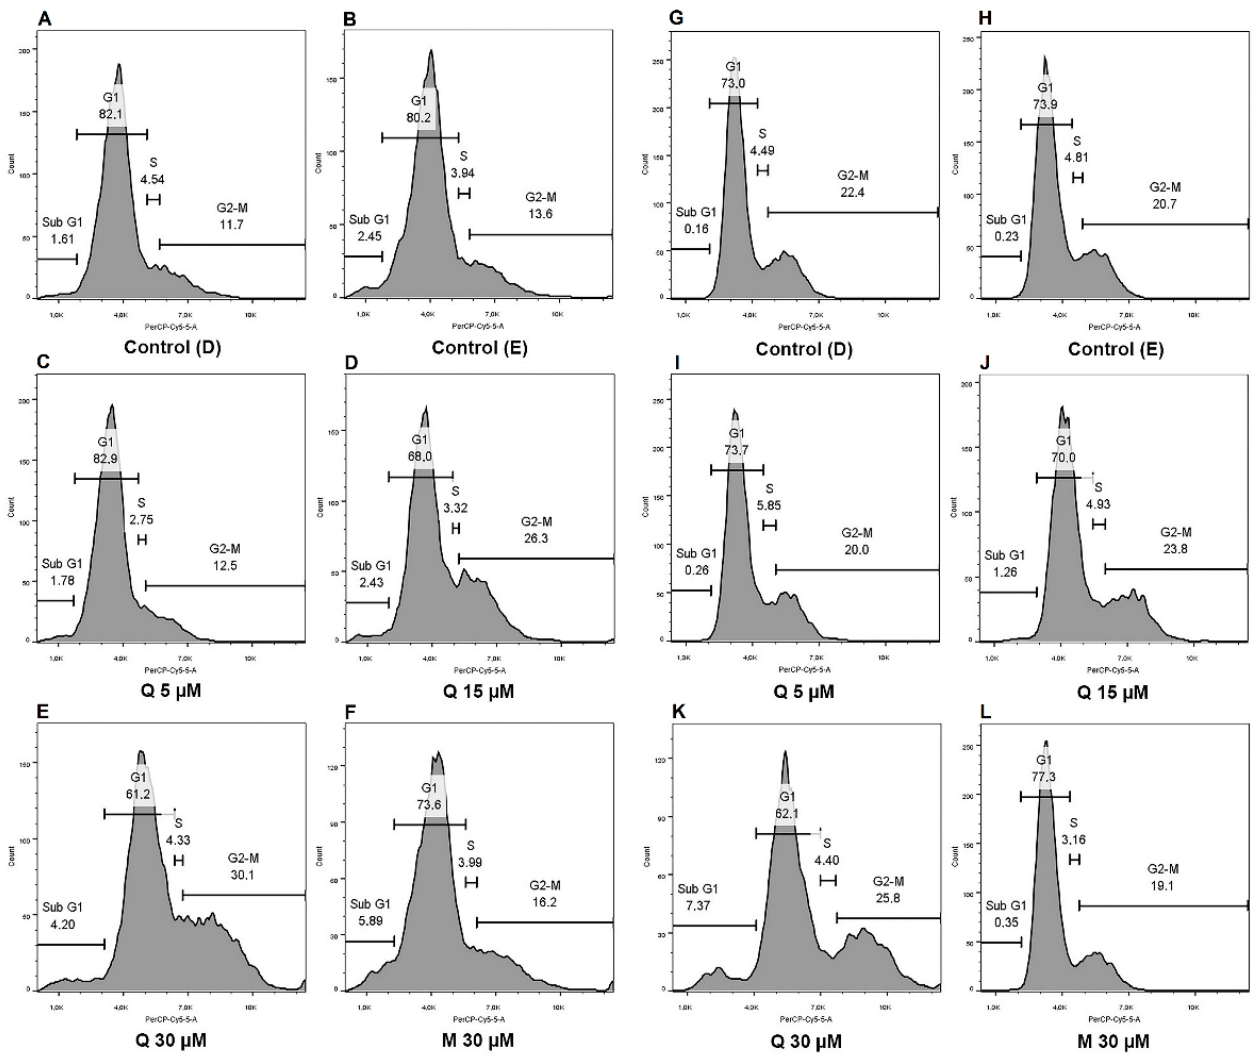
Figure 5. Quercetin and mitotane exerts different effects upon cell cycle after 48 h of treatment. ( A – F ) 7-AAD staining for the analysis of cell cycle dynamics on H295R cells; ( G – L ) 7-AAD staining for the analysis of cell cycle dynamics on SW-13 cells. Table 2. Percentage of 7-AAD staining on H295R and SW-13 cells, according to the cell cycle phase.